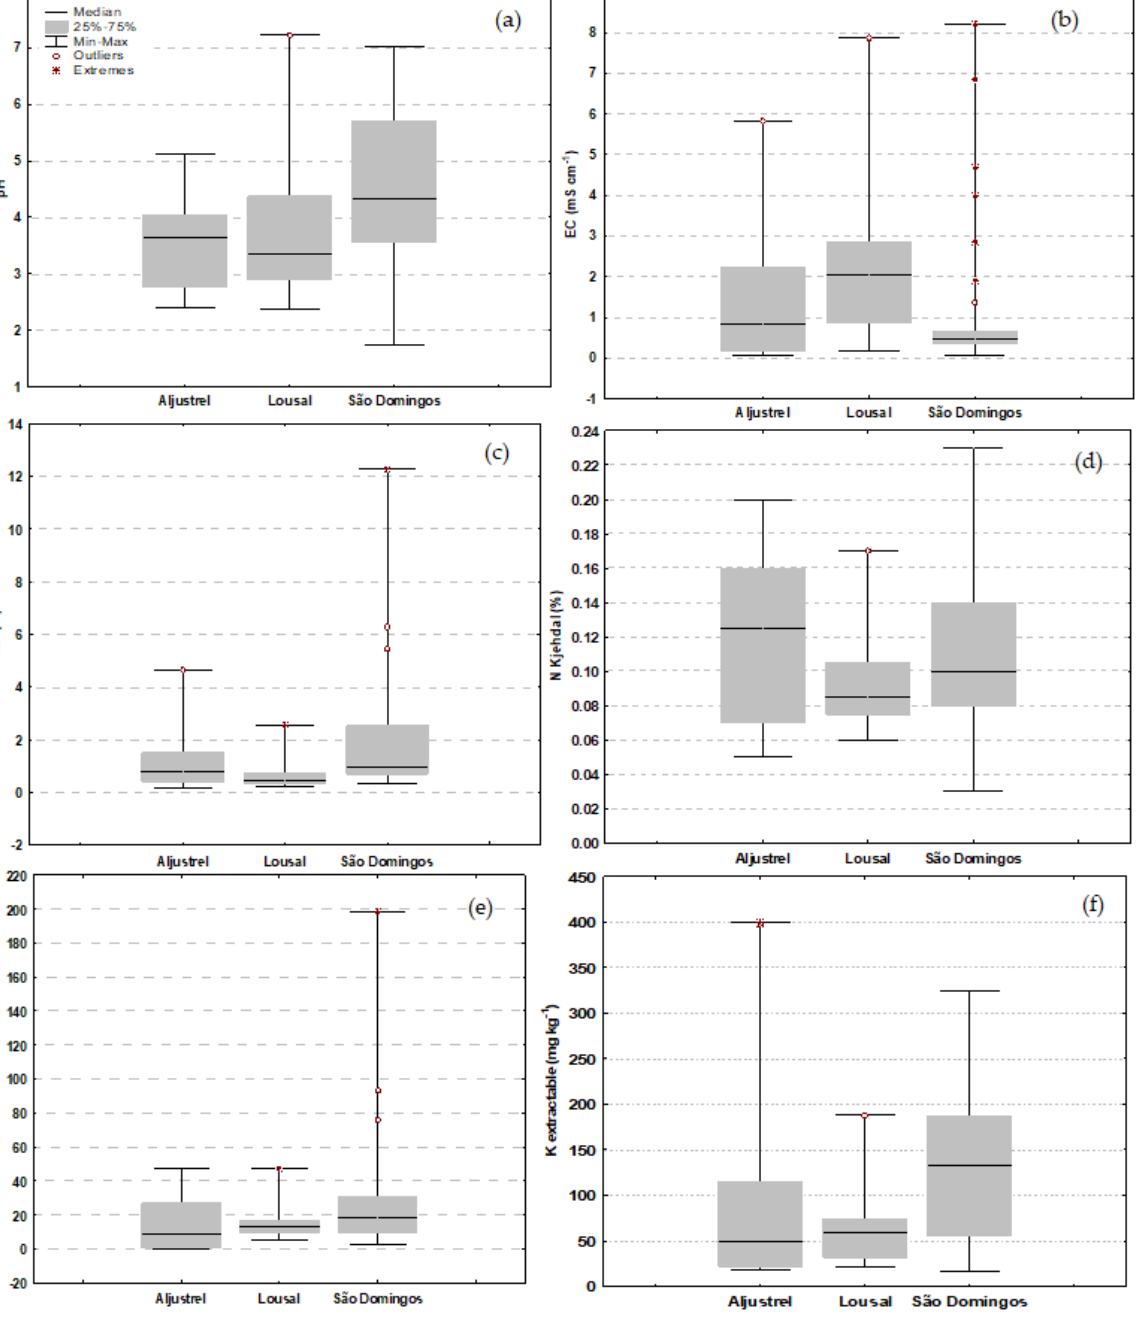
Figure 5. Boxplot representation of the most representative physicochemical properties to evaluate the fertility status of the soils in the different mining areas (sampling campaign July 2016): Aljustrel (n = 14), Lousal (n = 12), São Domingos (n = 44). ( a ) pH (H 2 O, 1:5 v / v ); ( b ) Electrical conductivity (EC, mS/cm, 1:5 v / v ); ( c ) Organic matter content (OM, % w / w ); ( d ) Kjeldahl N (%, w / w ); ( e ) extractable P (mg kg -1 ); and ( f ) extractable K (mg kg -1 ). The mark across the box represents the median and the bottom, and the top of the box represents the 25–75% interval. All results report to a dry matter basis. The soils were also characterized by very low OM content, with median values < 1% OM (g/100 g DW) for the three mines (Figure 5c) [49], and low macronutrients content, especially with total N and extractable P (Figure 5d,e). These values of extractable P in soils were considered as very low for this macronutrient in the three mines [49]. For extractable